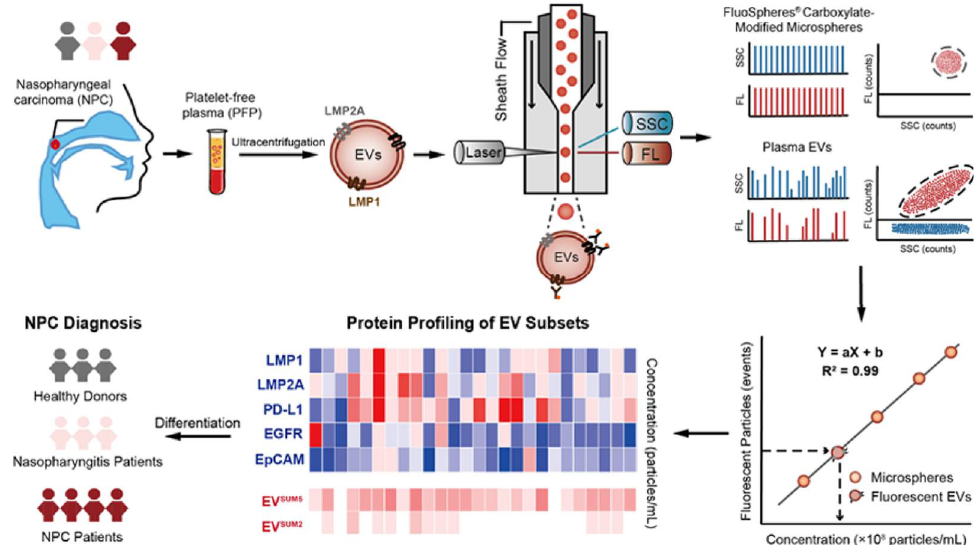
Figure 10. Phenotypic analysis of the plasma EVs for the detection of nasopharyngeal carcinoma. The exosome samples were isolated from plasma by ultracentrifugation. Reprinted with permission from [100]. Copyright 2022, American Chemical Society.